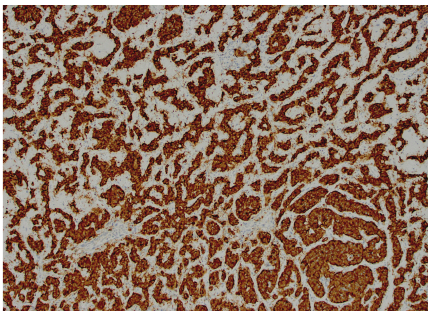
Figure 5: Neuroendocrine component (carcinoid) stained positive for synaptophysin.